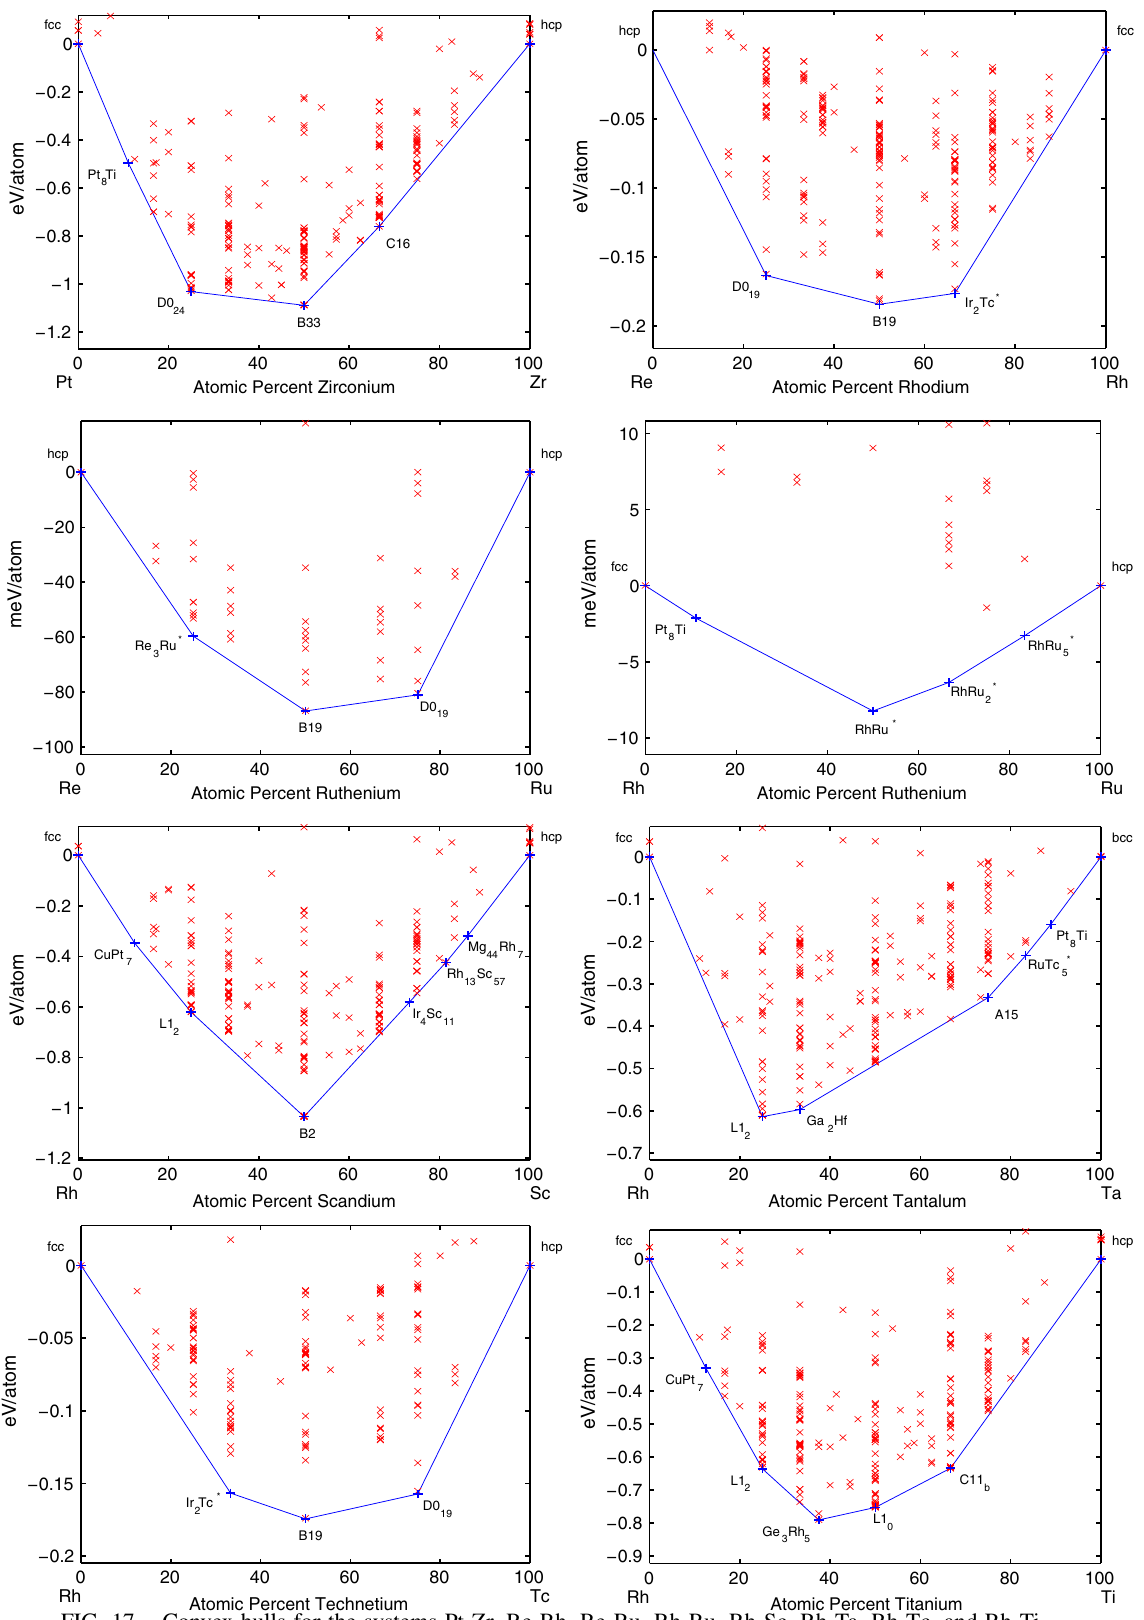
FIG. 17. Convex hulls for the systems Pt-Zr, Re-Rh, Re-Ru, Rh-Ru, Rh-Sc, Rh-Ta, Rh-Tc, and